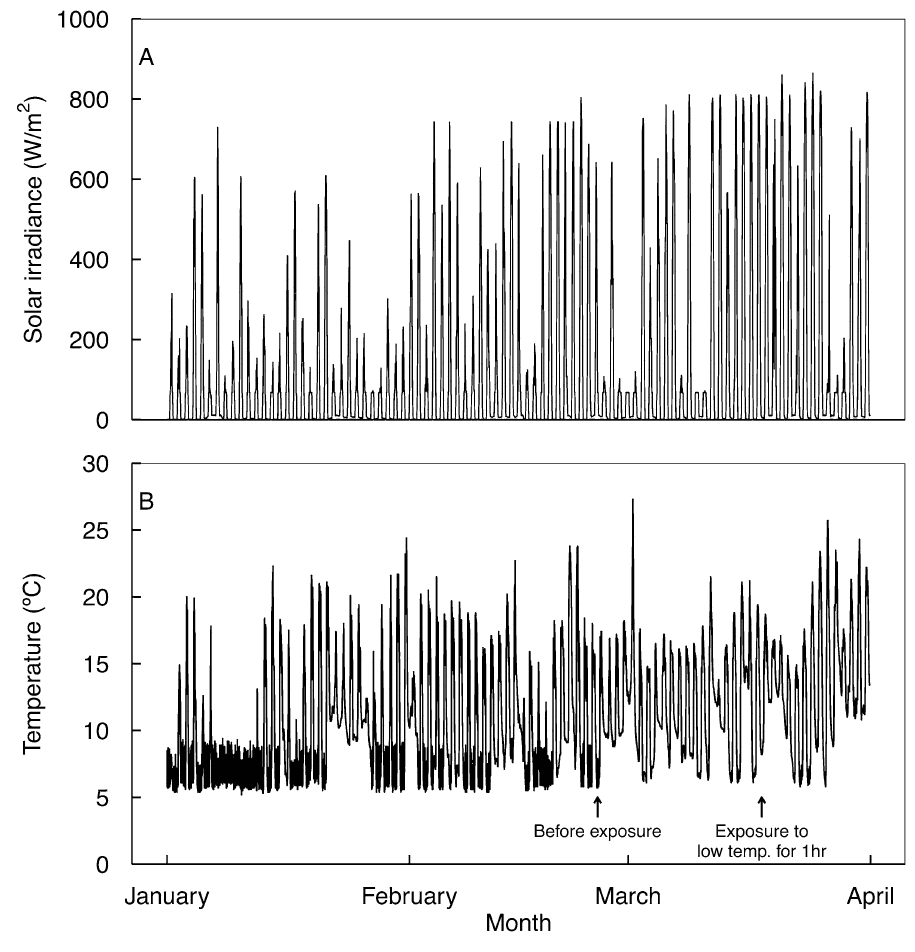
Figure 1. Solar irradiance ( A ) and temperature ( B ) from 01 January to 31 March 2021 in a greenhouse at the experimental orchard of the Research Institute of Climate Change and Agriculture, the National Institute of Horticultural and Herbal Science, Jeju (33° 28 ′ N, 126° 31 ′ E), Republic of Korea. ‘Hass’ three-year-old avocado seedling before treatment and treated to low temperatures were cultivated with the average growing temperature of 10.53 °C and 11.06 °C,